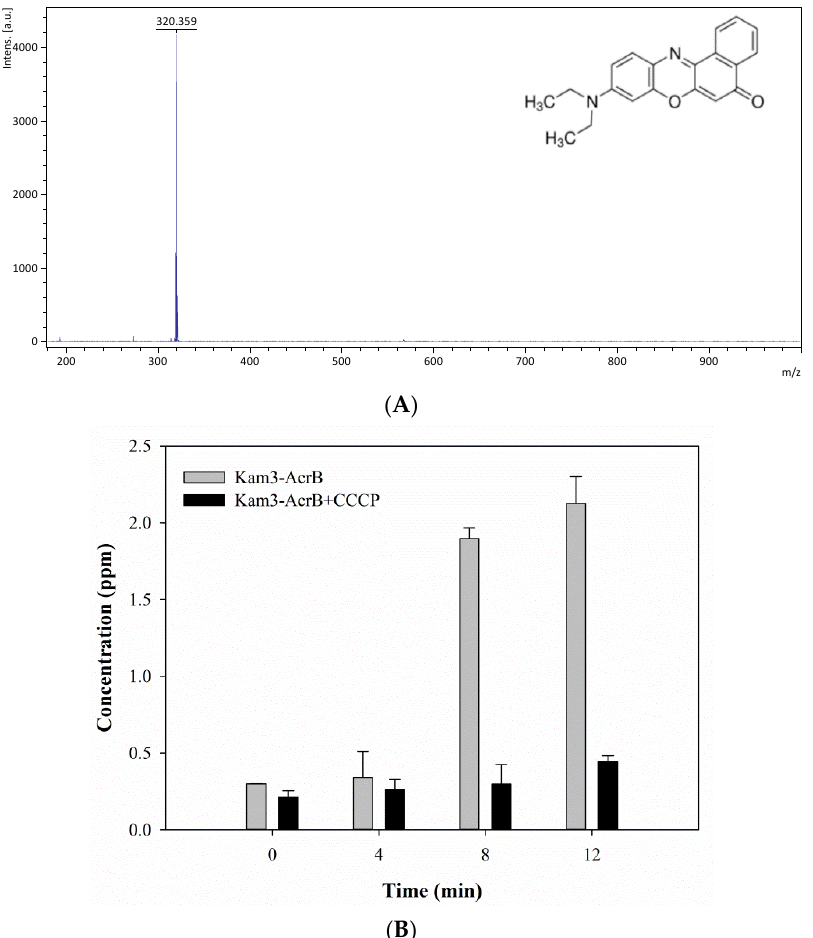
Figure 6. The Nile red efflux activity of Kam3-AcrB was detected by using MALDI-TOF MS in the presence of modulator CCCP. ( A ) The mass spectrum of Nile red and ( B ) the intensity of extracellular Nile red. The intensity was plotted at the main peak at m / z 320.36 of Nile red and the detection period was 12 min. Values are expressed as mean ± standard deviation (SD) ( n = 3).